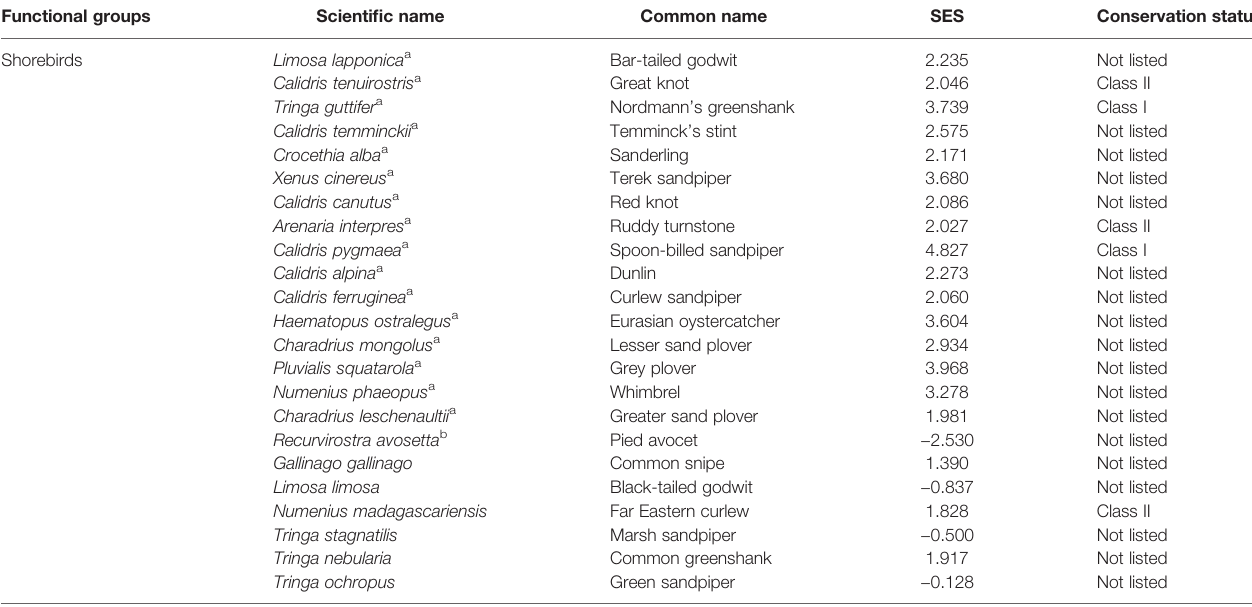
TABLE 1 | Dependence of waterbird species on coastal natural wetlands, standardized effect size (SES), and their conservation status. Functional